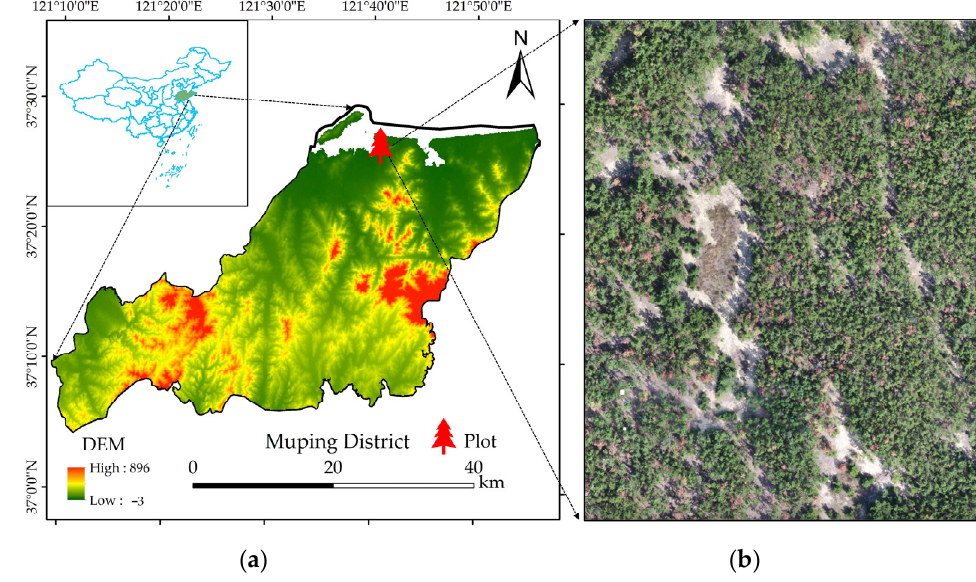
Figure 1. ( a ) Location of the study area; ( b ) UAV orthophoto of the study area.